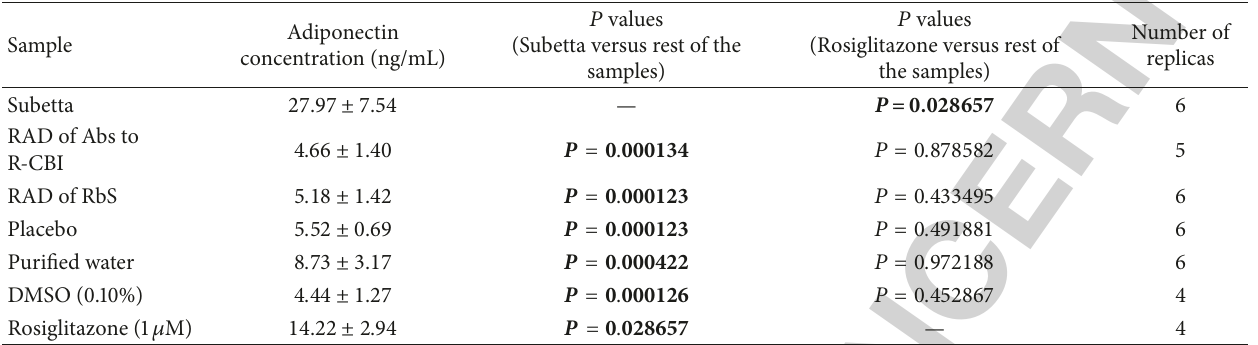
Table 1: Effect of Subetta and rosiglitazone on human adipocyte adiponectin secretion.